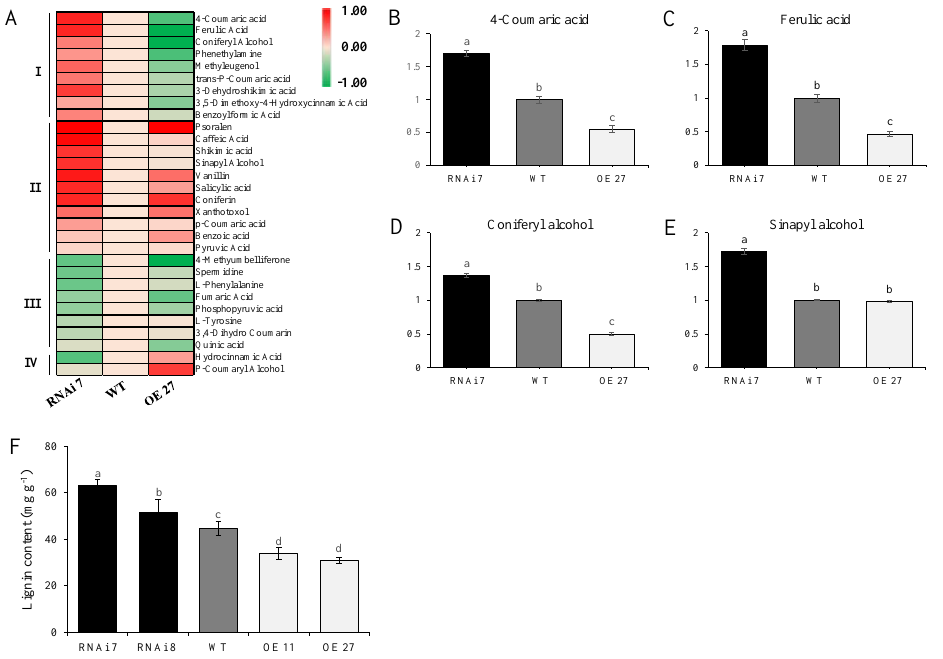
Figure 4. Lignin-related metabolites of control and StSN2 transgenic tuber periderm. ( A ) Heat maps of differentially accumulated metabolites (DAMs) related to lignin synthesis. Relative contents of four key precursors, 4-Coumaric acid ( B ), Ferulic acid ( C ), Coniferyl alcohol ( D ) and Sinapyl alcohol ( E ), for lignin synthesis were identified and quantified (LC-MS/MS). ( F ) Lignin content in the RNAi line, OE line and wild-type (WT) periderm. The data are means ± SD of four biological experiments with triplicate measurements in each experiment. Different letters indicate a significant difference at p < 0.05 among wild-type, overexpression and RNAi potato